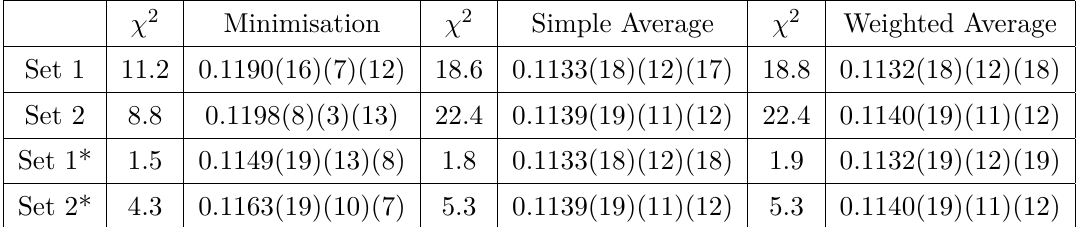
) obtained when the theory uncertainties originating Z